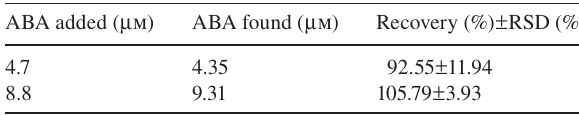
Table 2 Recoveries of ABA added to the seed extracts of maize by square-wave adsorptive stripping voltammetry at pencil-lead BiFE a